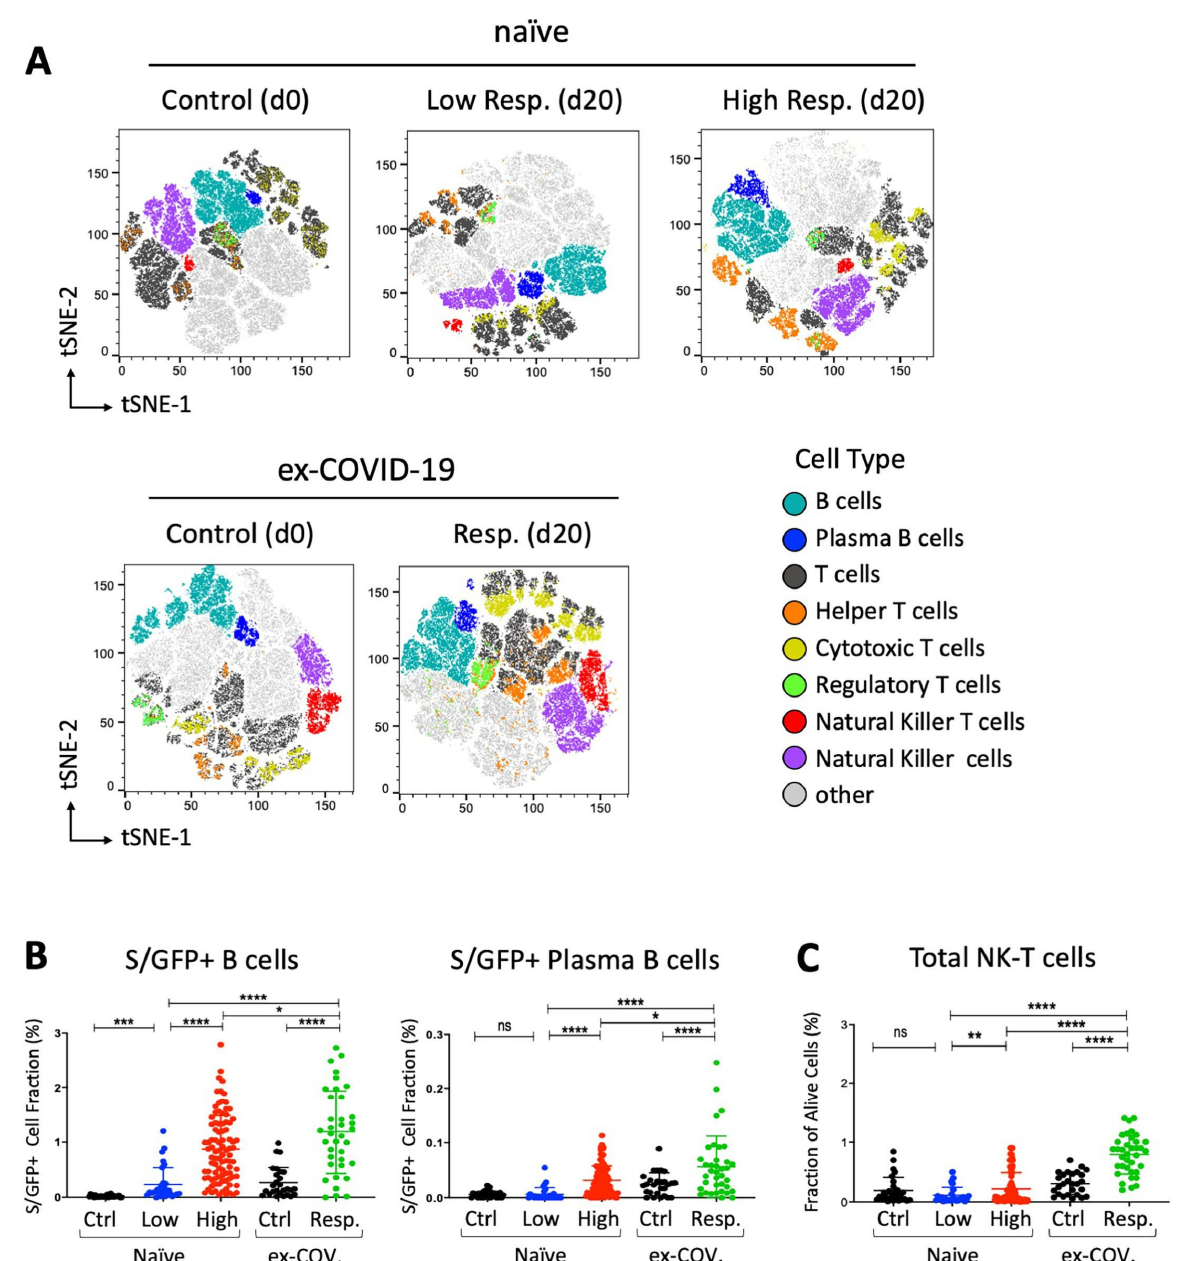
Figure 2. Distribution of spike/RBD ‐ specific B cells and total NK ‐ T cell subset in response to BNT162b2 vaccine. ( A ) tSNE map based on the flow cytometry data from participants, subdivided into low ‐ (N = 30) and high (N = 93) ‐ response “naïve” individuals at day 20 and control (N = 30) at day 0. Flow cytometry data from seropositive (ex ‐ COVID ‐ 19) individuals at days 0 and 20 were also analyzed and reported as response (N = 37) and control (N = 27) respectively. Only individuals from the same geographic area and of similar ages have been collected and selected for the reported assay . A total of 100,000 live lymphocytes for each sample were considered for concatenation and downsampling. t ‐ SNE dimensional reduction was performed for the visualization of cell subsets for each cohort in two dimensional plots using standard parameters (perplexity = 30, theta = 0.5). ( B , C ) GFP+ B cell fraction as result of interaction with the recombinant GFP ‐ tagged SARS ‐